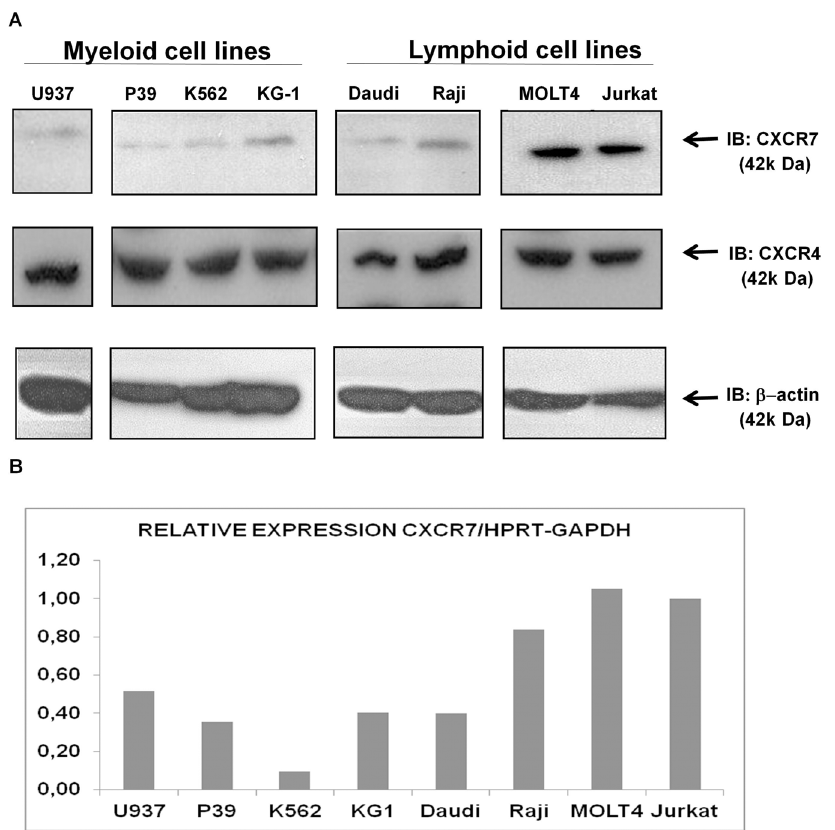
Figure 4. Higher expression of CXCR7 in T-acute lymphoid leukemia lines MOLT4 and Jurkat. A) Western blot analysis of CXCR7 protein levels in myeloid (U937, P39, K562 and KG-1), B-lymphoid (Daudi, Raji) and T-lymphoid (MOLT4 and Jurkat) cell lines. Total cell extracts were blotted with antibodies against CXCR7 (42 kDa), CXCR4 (42 kDa) or b -actin (42 kDa), as a control for equal sample loading, and developed with the ECL Western Blot Analysis System. CXCR7 protein was detectable in all acute leukemia cell lines; however CXCR7 was more expressed in the T-acute lymphoid cell lines MOLT4 and Jurkat when compared to other cell lines. CXCR4 proteins levels were homogeneous in all cell lines analyzed. B) Quantitative expression of CXCR7 mRNA in leukemic cells lines. mRNA expression levels of CXCR7 were normalized by HPRT and GAPDH endogenous